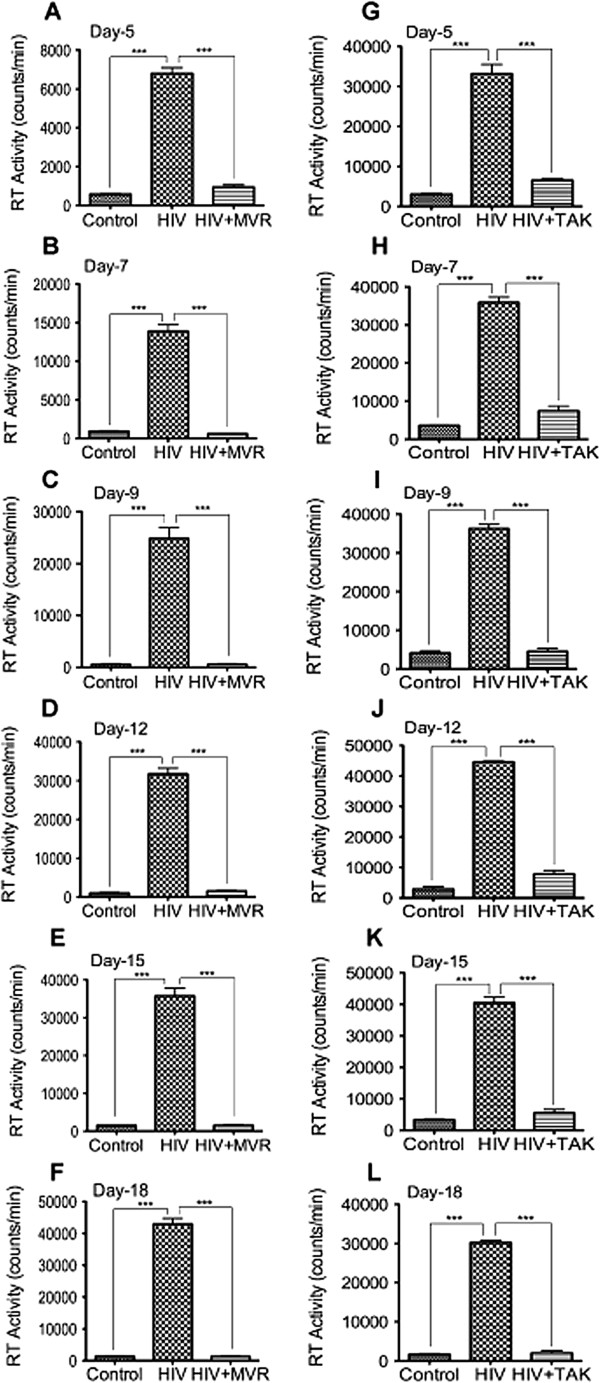
CCR5 antagonists inhibits HIV-1 infection in MDM. MDM were infected with the macrophage tropic HIV-1ADA, with or without maraviroc or TAK-779 (5 μM) in the media. Controls consisted of mock-infected cells. Culture supernatants were then collected every 2 or 3 days from day-5 to day-18 post-infection (p.i) and viral replication estimated by quantifying reverse transcriptase activities. From day-5 to day-18 p.i., both maraviroc (A-F) and TAK-779 (G-L) inhibited HIV-1 infection of MDM (***P < 0.001). This is representative data from 3 independent experiments with 3 different human donors, with each donor tested in triplicate.